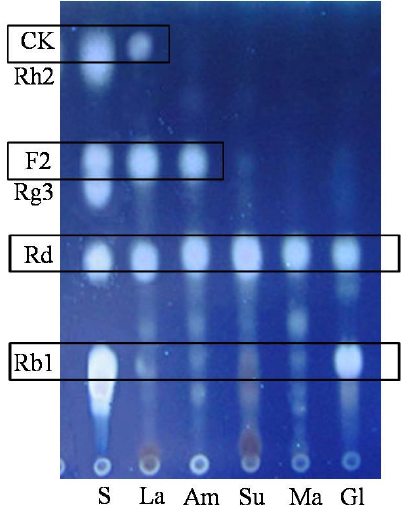
Figure 3. Influences of different carbon sources on the biotransformation of Rb1. La: lactose; Am: amidulin; Su: sucrose; Ma: maltose; Gl: glucose.